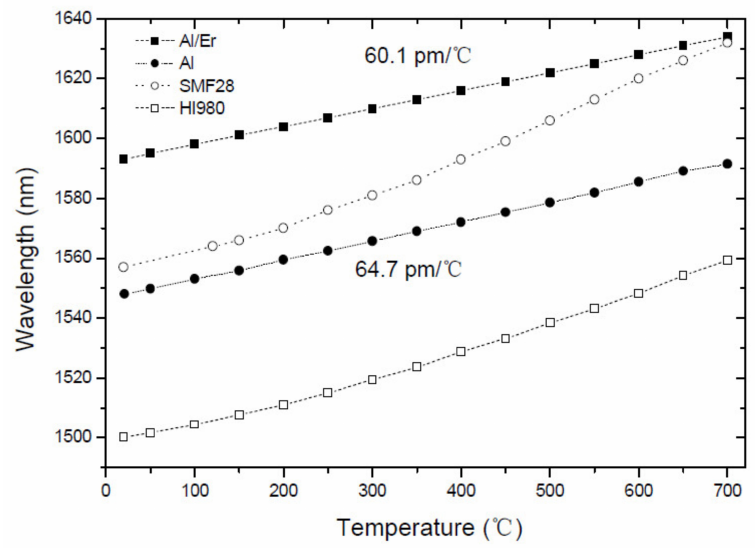
Figure 4. Comparison of the thermal behavior of LPFGs arc-induced in Ge-doped and in aluminosili- cate fibers. Reprinted from